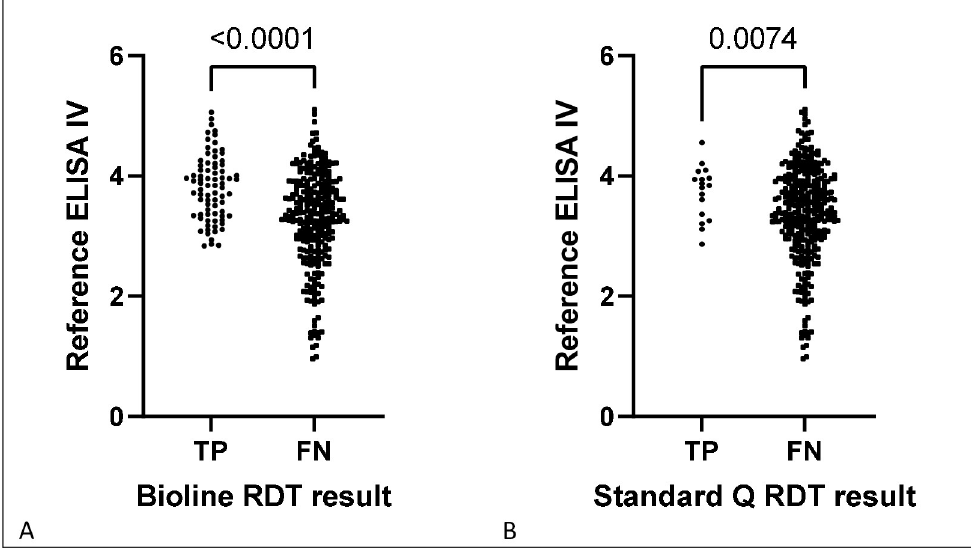
Fig 1. Comparison of reference enzyme-linked immunosorbent assay (ELISA) index values (as a proxy for antibody concentration) between individuals who were rapid diagnostic test (RDT) -true positive (TP) and RDT-false negative (FN) when Bioline Dengue IgG/IgM, Abbott (A) and Standard Q Dengue IgM/IgG, SD Biosensor (B) assays were used under field conditions.